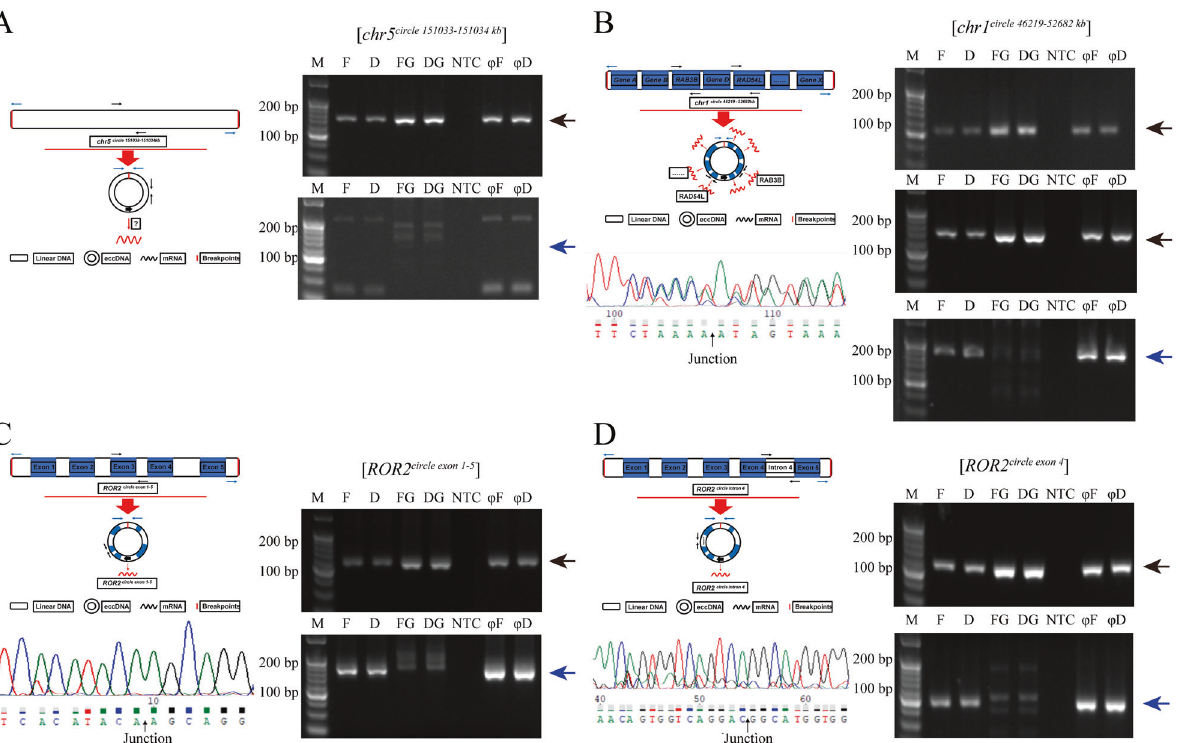
Fig. 3 EccDNA validation. A Gel images for validated eccDNAs ampli fi ed with no gene ([ chr5 circle 151033-151034 kb ]). B eccDNA ampli fi ed with multiple coding genes ([ chr1 circle 46219-52682 kb ]). C eccDNA ([ ROR2 circle exon 1-5 ] and ( D ) [ ROR2 circle intron 4 ]) by outward PCR (blue arrows), inward PCR (black arrows), gel electrophoresis, schematic diagram and Sanger sequencing. EccDNAs are named according to gene content. blue boxes: exons. M: Marker. F: eccDNA of FaDu cells. D: eccDNA of FaDu/DDP cells. FG: genomic DNA of FaDu cells. DG: genomic DNA of FaDu/ DDP cells. φ F: phi29 ( φ ) ampli fi ed eccDNA of FaDu cells. φ D: phi29 ( φ ) ampli fi ed eccDNA of FaDu/DDP cells. NTC: nontemplate